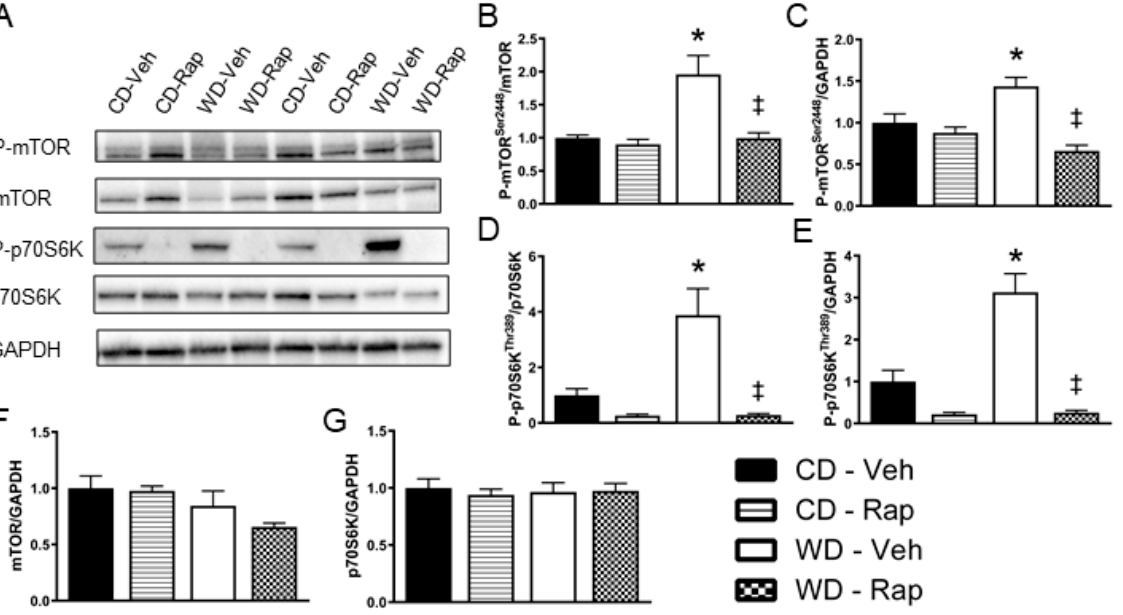
Figure 2. Assessment of mTOR signaling in the corpus cavernosum. Mice were fed the control (CD) or Western (WD) diet and treated with vehicle or 2 mg/kg rapamycin (Rap). ( A ) Representative immunoblot images for phosphorylated mTOR at Ser2448, total mTOR, phosphorylated p70S6K at Thr389, total p70S6K, and the loading control GAPDH. Quantification of band intensity density for: ( B ) phosphorylated mTOR normalized to total mTOR; ( C ) phosphorylated mTOR normalized to GAPDH; ( D ) phosphorylated p70S6K normalized to total p70S6K; ( E ) phosphorylated p70S6K normalized to GAPDH; ( F ) total mTOR normalized to GAPDH; ( G ) total p70S6K normalized to GAPDH. Data are presented as mean ± standard error of the mean for n = 8 mice per group; * p < 0.05 vs. CD-Veh, ‡ p < 0.05 vs. WD-Veh.